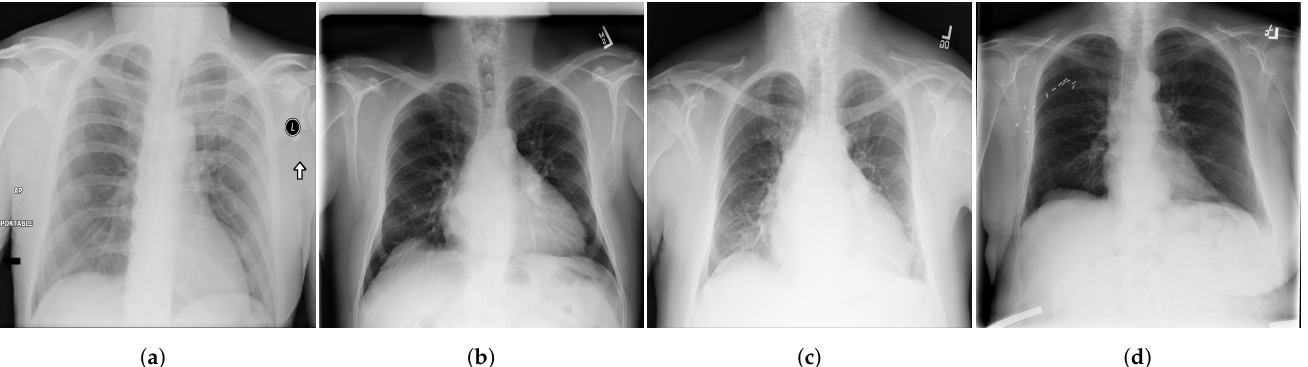
Figure 2. Examples of CXR images from ChestX-ray14 dataset [39] where, ( a ) Nodule; ( b ) Emphysema; ( c ) Effusion; ( d )